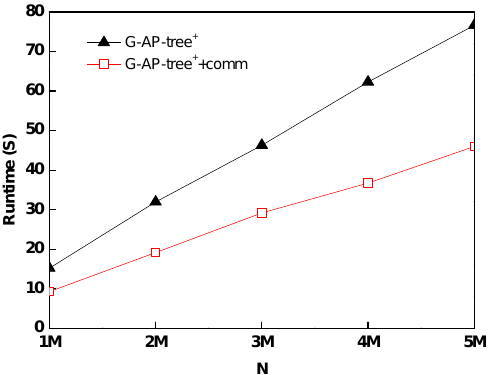
Figure 15. Evaluating the query performance of G-AP-tree + with the communication